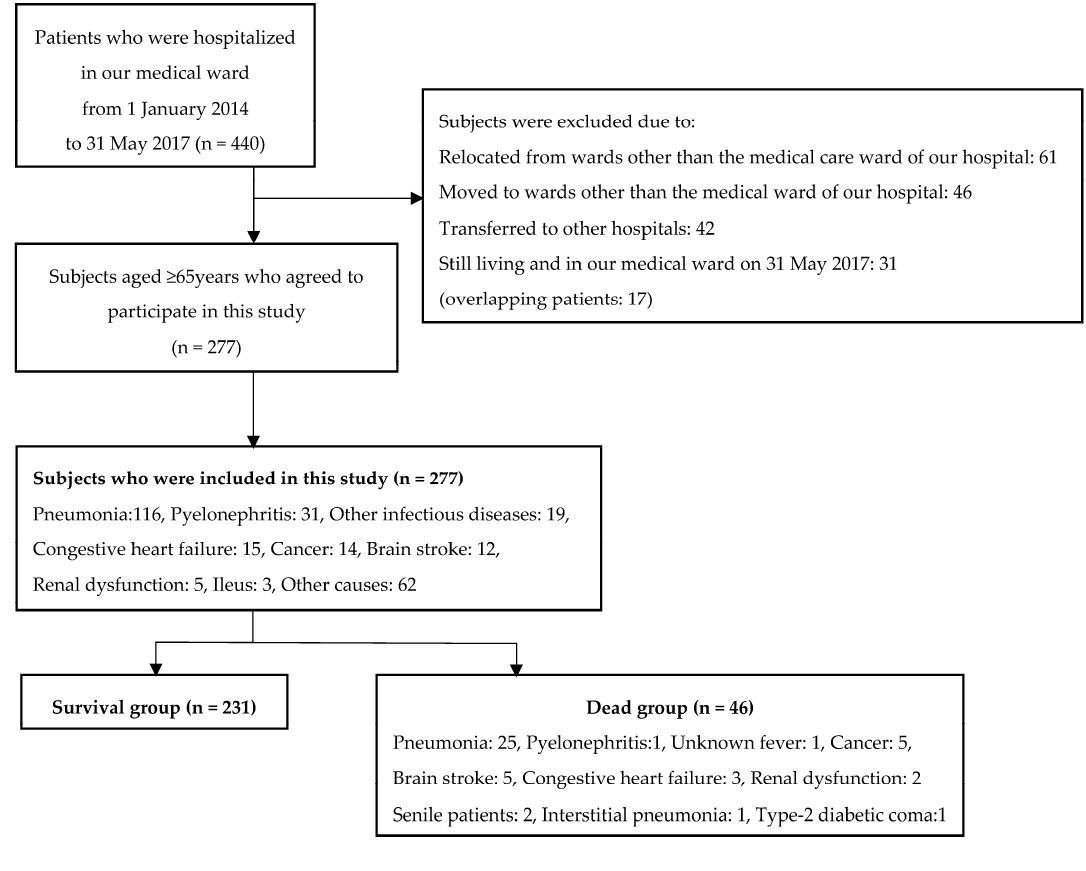
Figure 1. The flowchart of the study design. Table 1. Independence degree of daily living for the disabled